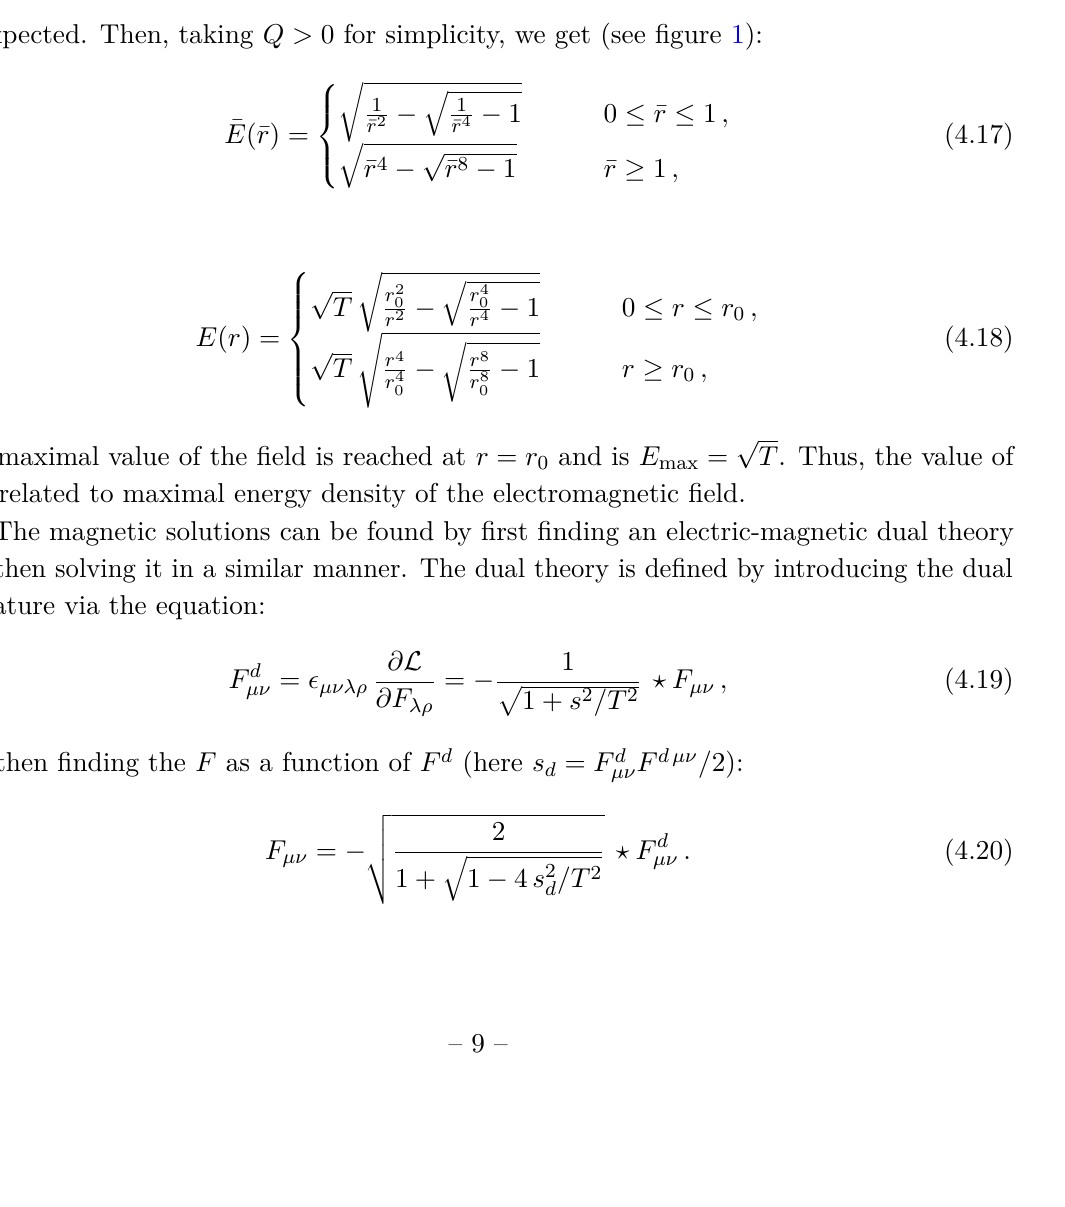
Figure 1 . The solution (4.18) compared to Coulomb